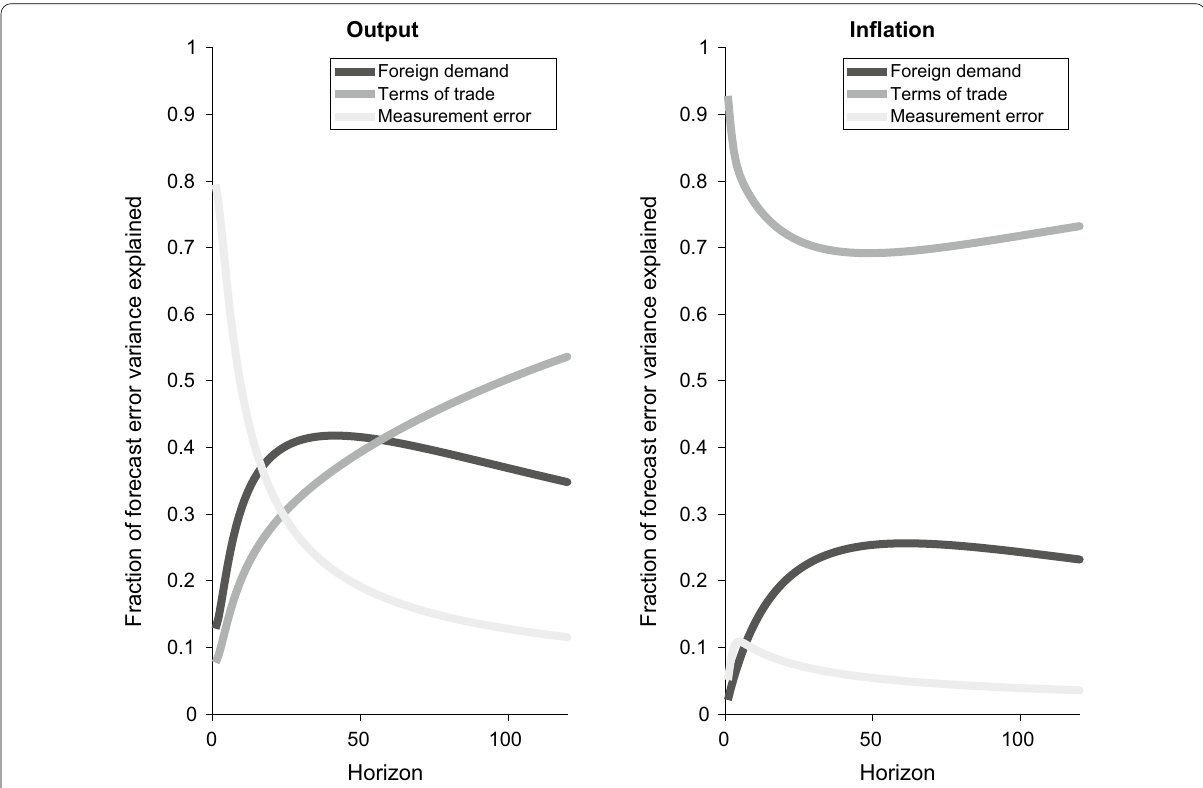
Fig. 3 Forecast Error Variance Decomposition. Results are based on median outcomes of the posterior